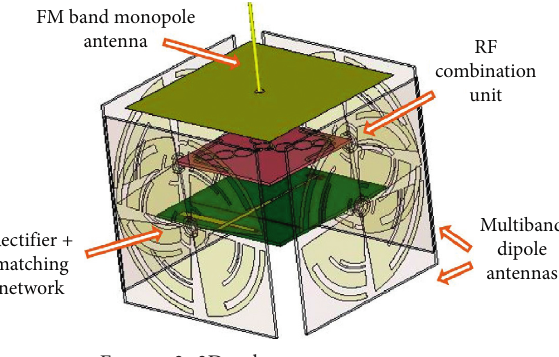
Figure 2: 3D cube rectenna